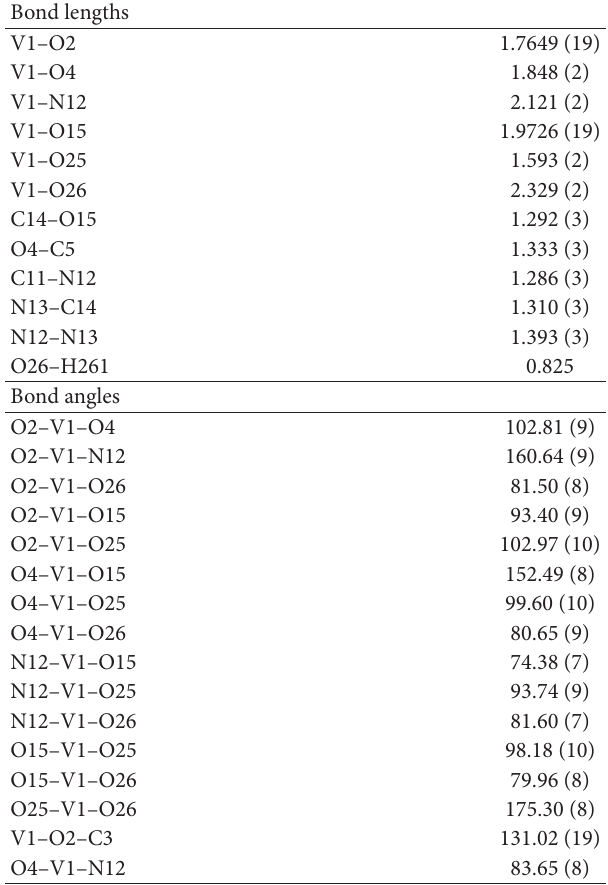
) for 1 . T 3: Selected bond lengths (Å) and angles ( ∘